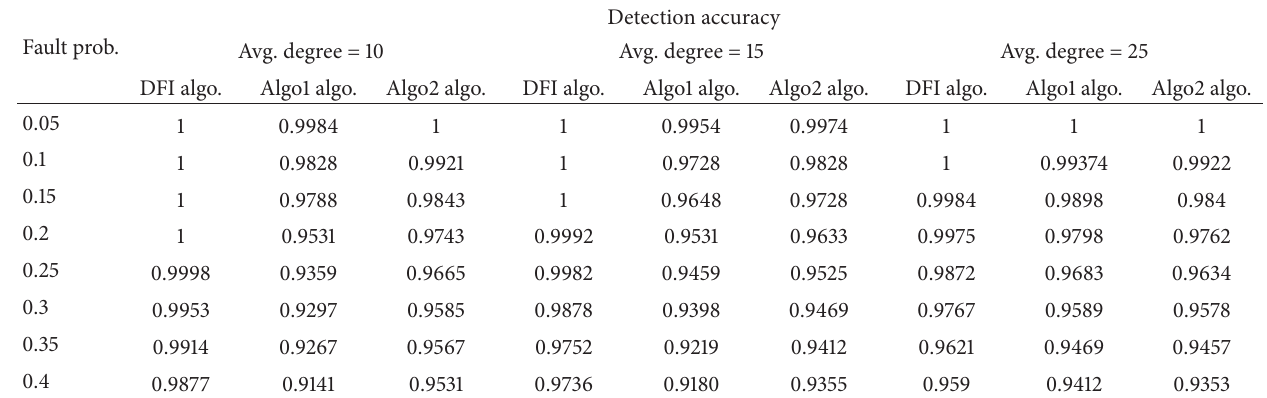
Table 3: Comparison of DA for different algorithms.